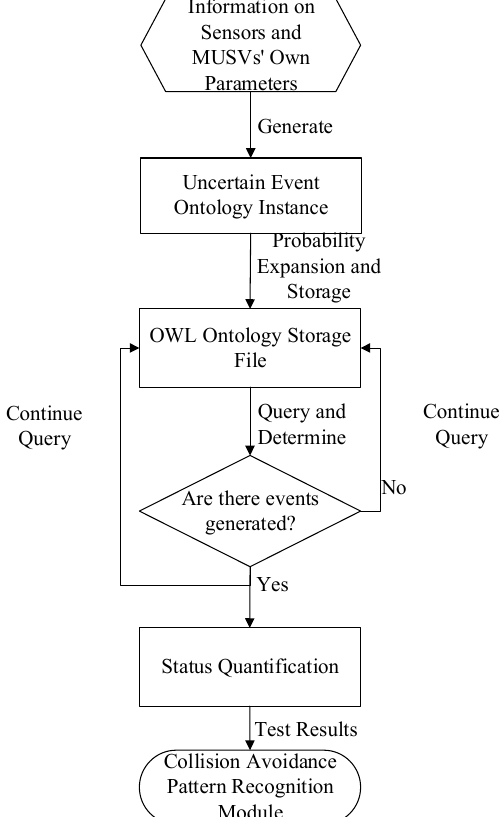
Figure 4. Flow chart of uncertainty event detection.